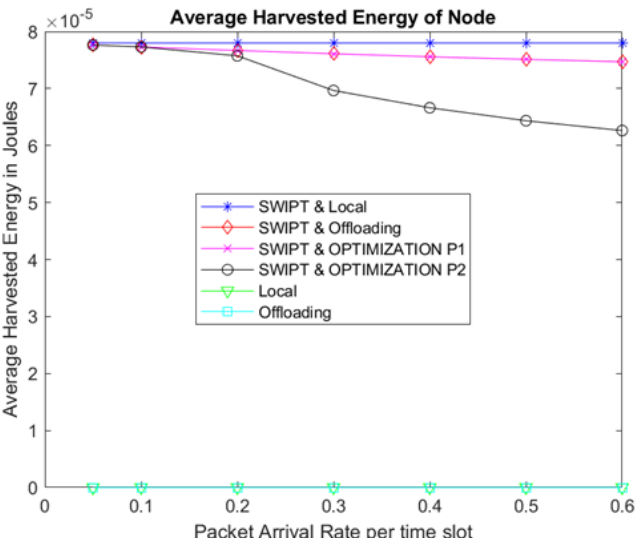
Figure 18. Average harvested energy of the end node with variable packet arrival